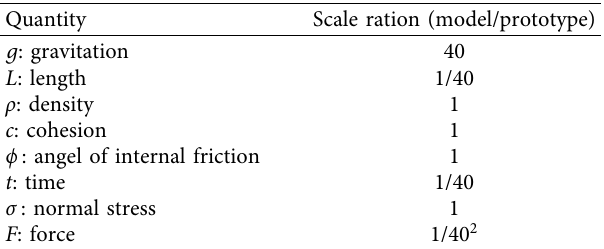
Table 2: Scale ration related to pipe modeling.